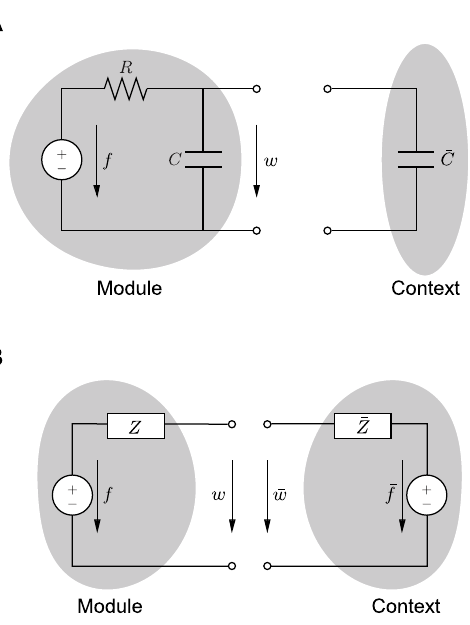
Figure 9. Analogy with electrical systems. (A) The module consists of the series interconnection of a voltage source f , a resistor R and a capacitor C . The speed of the module can be characterized by the time constant t ~ RC , which increases upon interconnection with the context. The greater C , the slower the module in isolation, but the smaller the percentage change in its speed upon interconnection. (B) According to the fundamental theorem by Thevenin [48], any linear electrical network can be equivalently represented by a series interconnection of a voltage source and an impedance. As a result, a generic module consists of the series interconnection of a voltage source f and an impedance Z , and similarly, any context can be represented with the series interconnection of (cid:2) ff and (cid:2) ZZ .